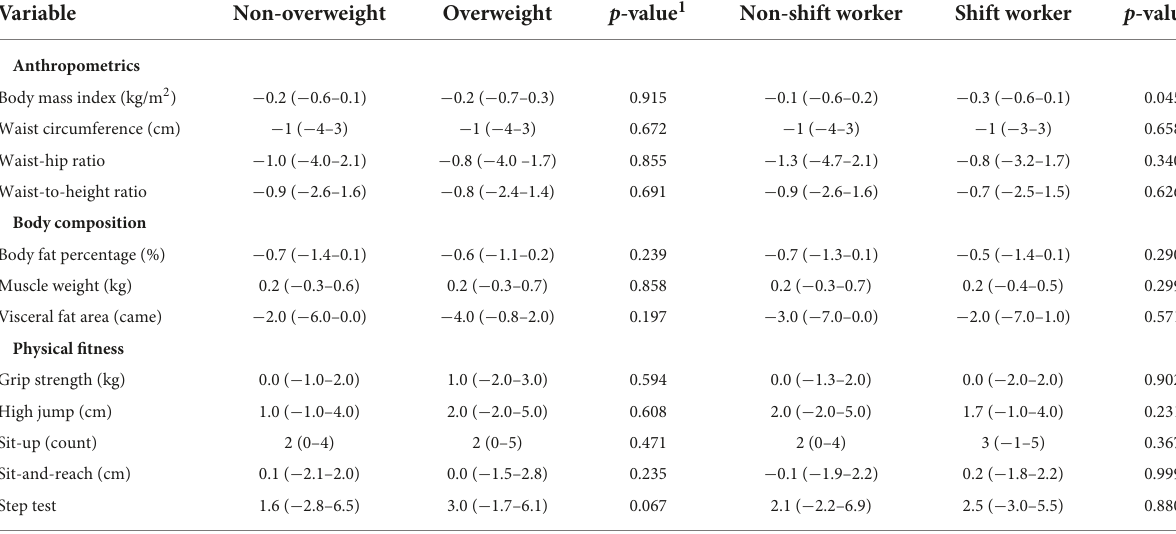
TABLE 4 Changes in outcome parameters stratified by weight status and shiftwork status.